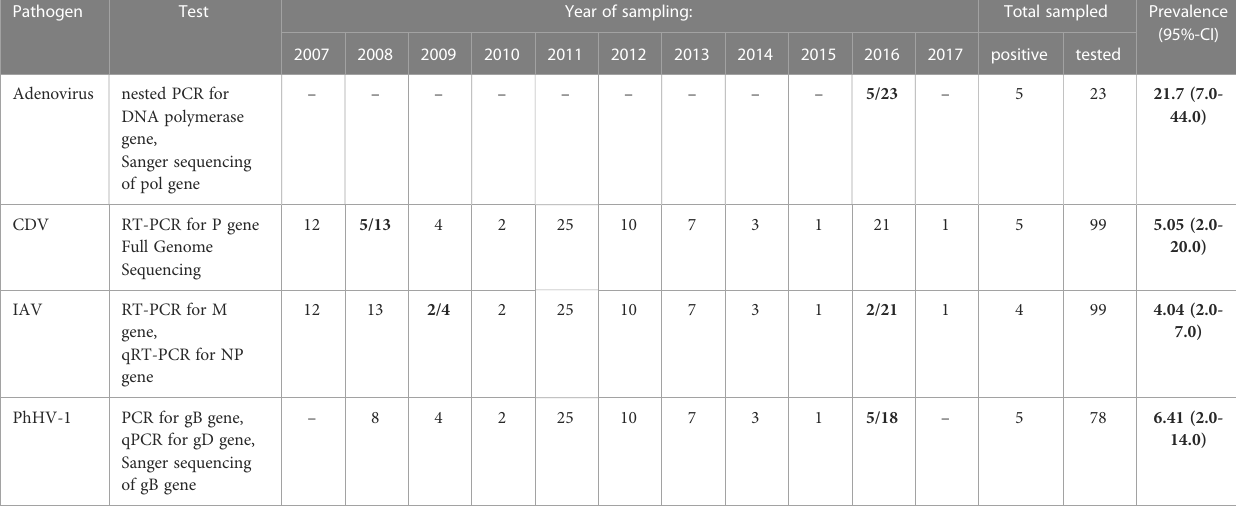
TABLE 1 Prevalence of CDV, In fl uenza A Virus, PhHV-1 virus, and Adenovirus detected via RT-PCR and PCR in Caspian seals. Pathogen